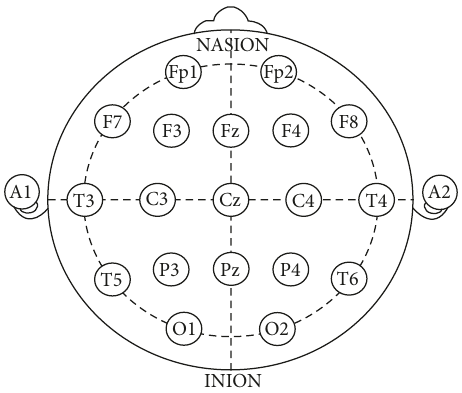
Figure 1: International 10–20 system.